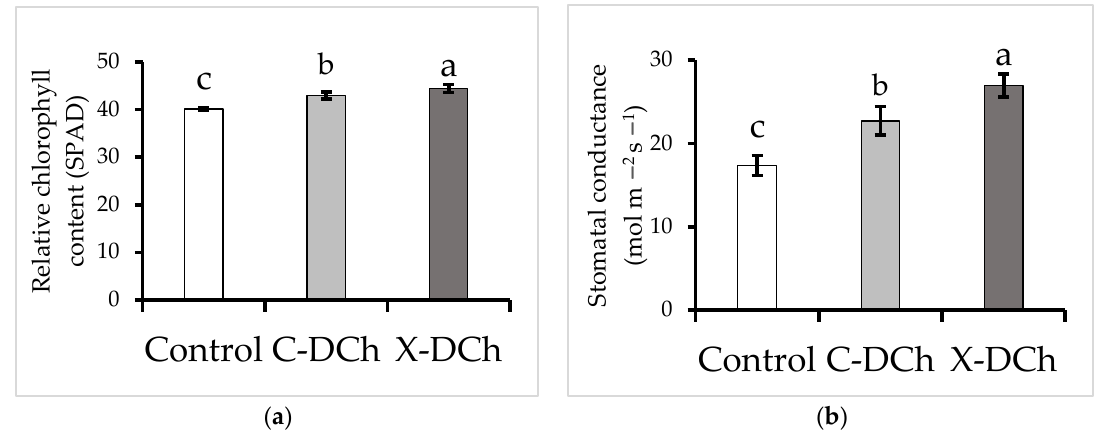
Figure 1. Relative leaf chlorophyll content (SPAD) ( a ) and stomatal conductance ( b ) of pineapple lily treated with carrageenan-depolymerized chitosan (C-DCh) and xanthan-depolymerized chitosan (X-DCh). Data are presented as means (±SD) and bars with different letters in each graph are significantly different by Duncan’s Multiple Range Test (DMRT) at α ≤ 0.05.